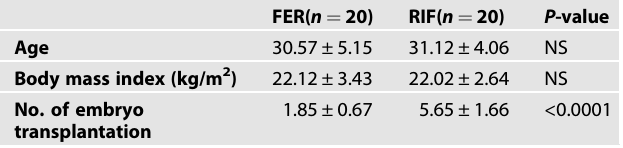
Table 1. Demographic details of the participants in the study of endometrial MEKK4, HOXA10 and ITGB3